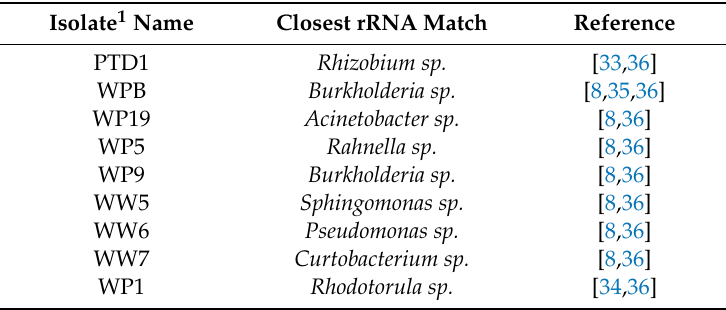
Table 1. Composition of the endophyte consortium used in the